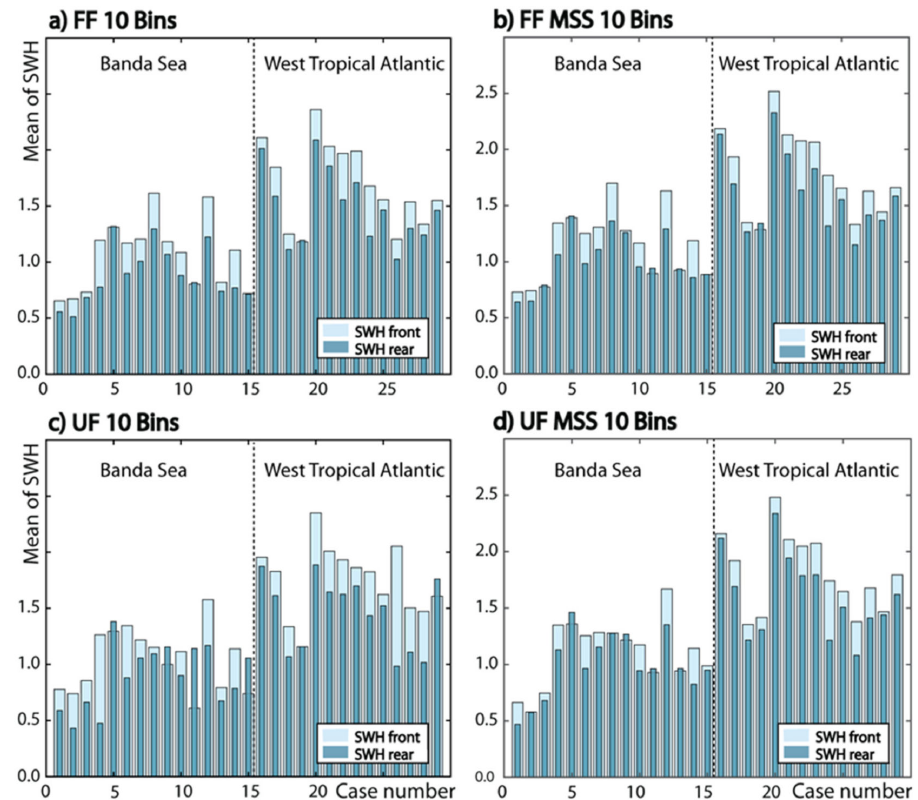
Figure 8. Bar plots representing significant wave heights (SWHs) for leading (front) and trailing (rear) sections of the ISWs for all cases in Table S1 using different algorithms: ( a ) FF 10 Bins. ( b ) FF MSS 10 Bins. ( c ) UF 10 Bins. ( d ) UF MSS 10